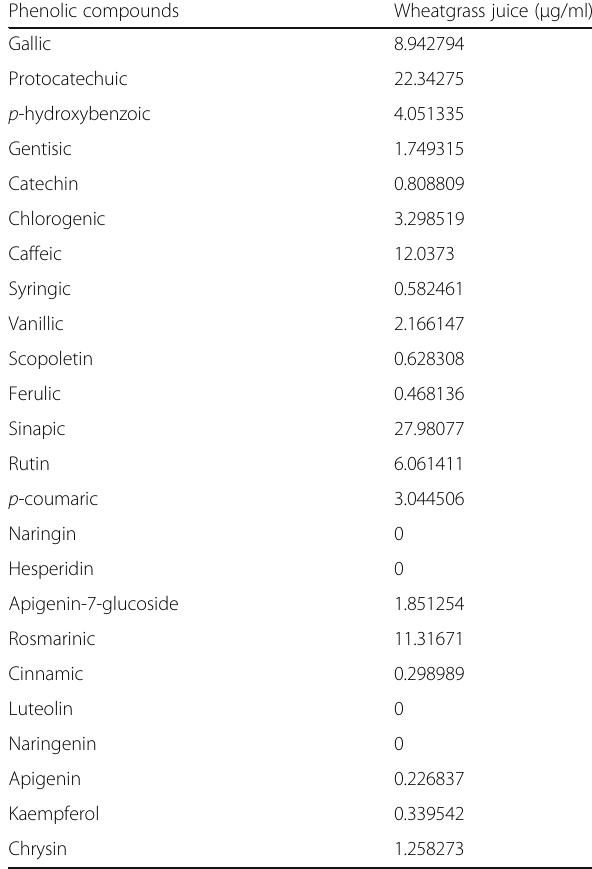
Table 4 Phenolic acid compound profiles in wheatgrass juice Phenolic compounds